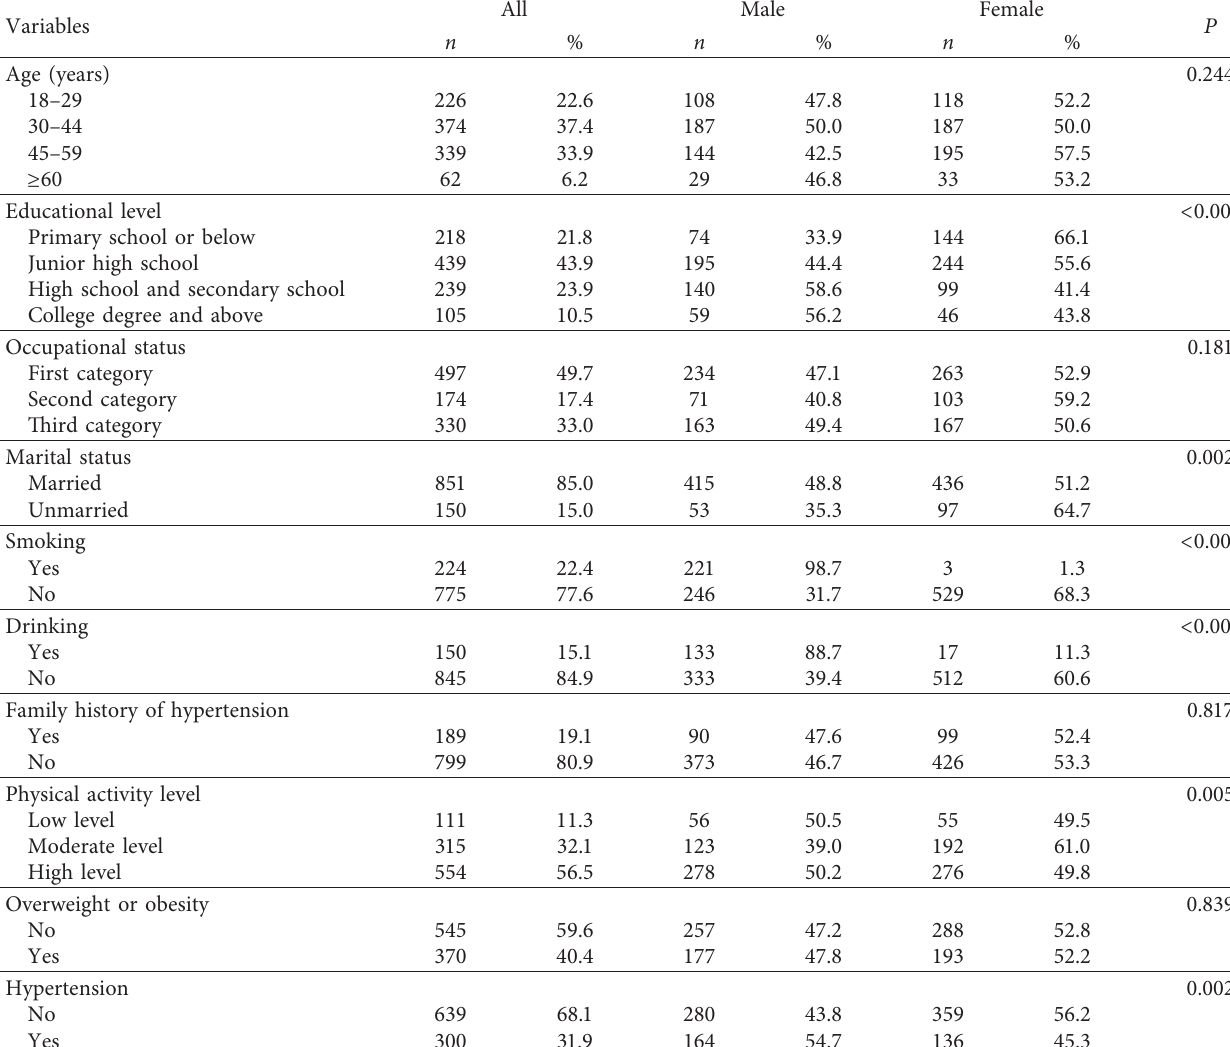
Table 1: Individual characteristics of study participants, overall and by